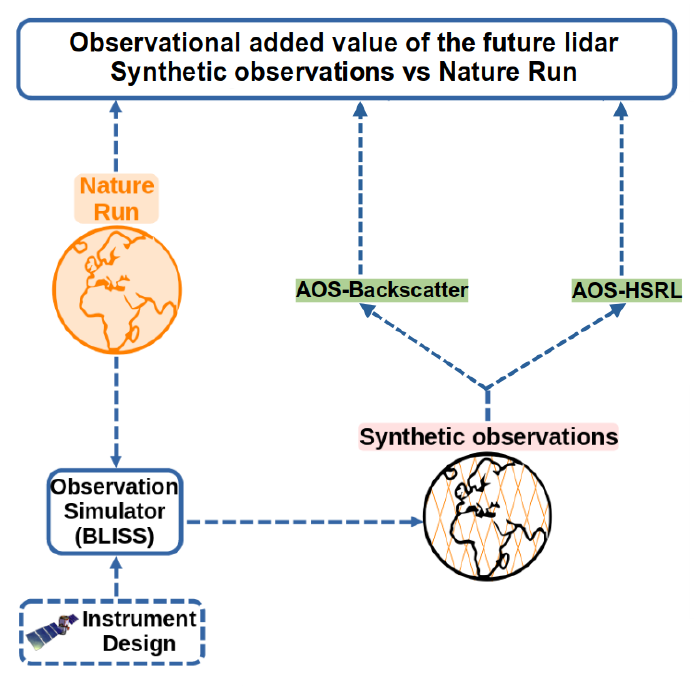
Figure 1. Schematic representation of the experience